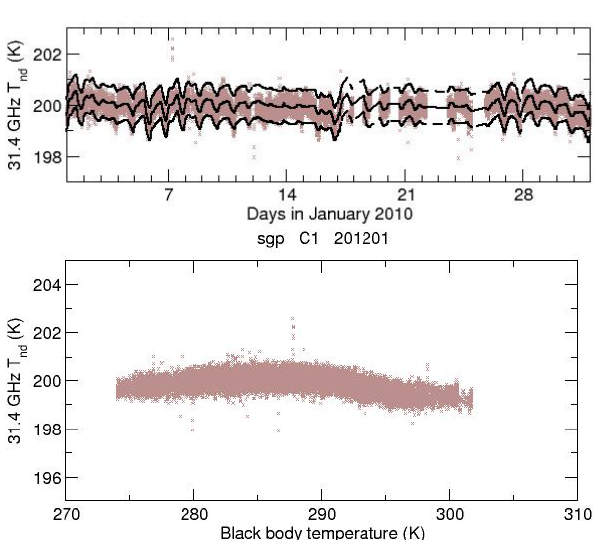
Fig. 2. Self-calibration of the ARM MWRs. Top: brown points are instantaneous noise injection temperature values derived from tip calibration. The black solid line is the median calculated value and the dashed lines are 2 standard deviations of the measurements. Bot- tom: dependence of the noise diode temperature on ambient temper- ature. The data were collected at the SGP site during the month of January